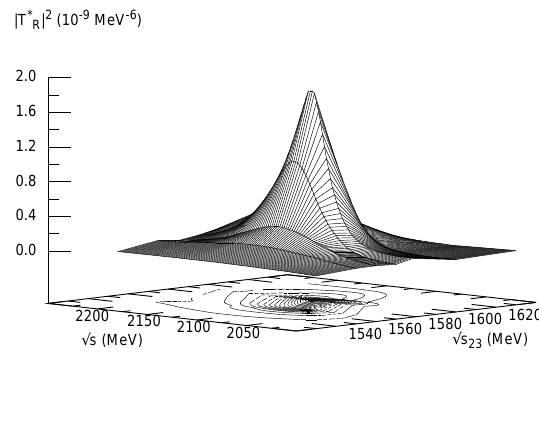
Fig. 2. The N ∗ (2100) in the ππ N system with five coupled chan- nels.